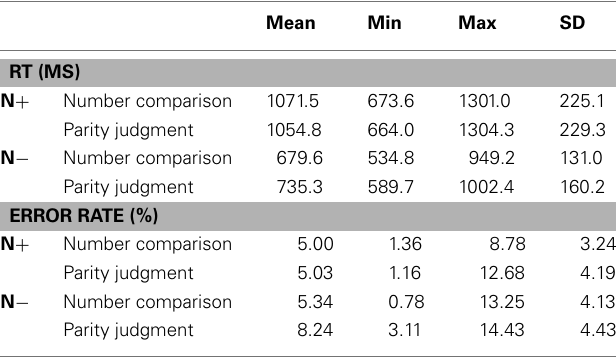
Table 2 | Descriptive statistics for RTs and error rates, as a function of task and